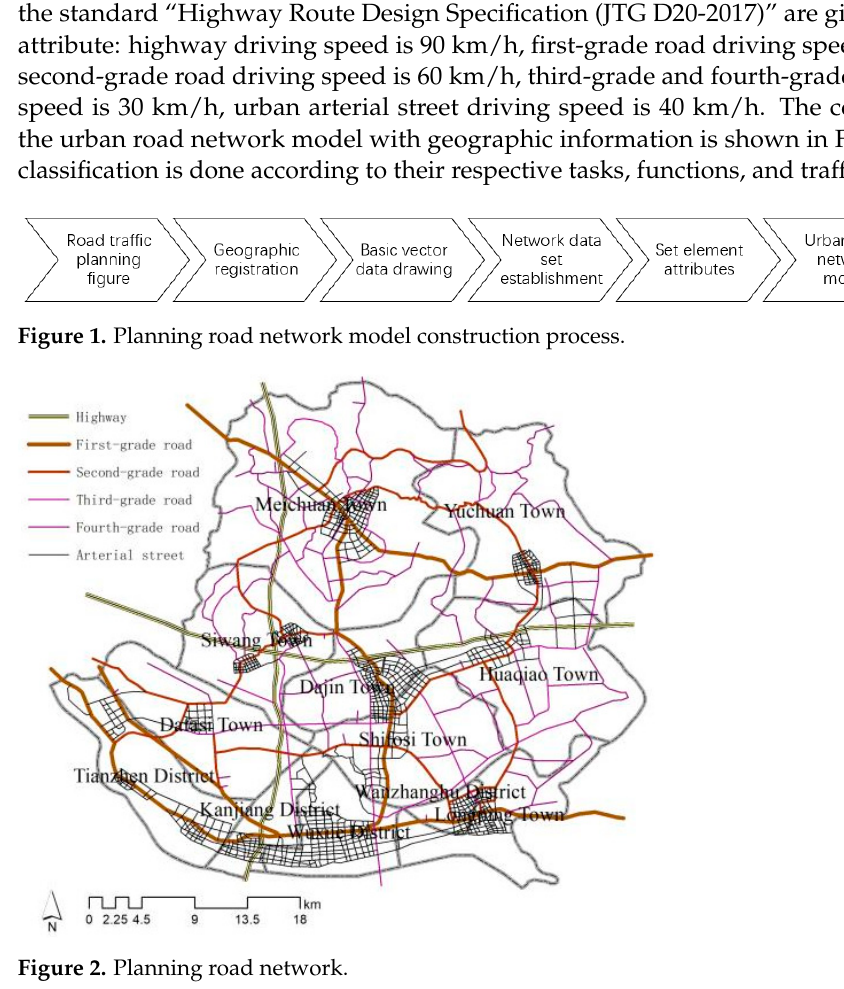
Figure 4. Number of base stations in each administrative region. 3.3. Test Methods Based on cell phone data, we mainly carried out research using ArcGIS software. We obtain the spatial distribution of travel OD, and then quantitatively analyze the main con ‐ tact directions and contact strengths among cities and towns in the city. Then, we under ‐ take an evaluation of the current planning scheme in four aspects, such as road network density and traffic accessibility, and make optimization suggestions. The research process is as follows (Figure 5). The first is spatial analysis of cell phone data. The cell phone data used in this study contain the geographical coordinates of the start and end points and the amount of traffic each day. We analyze people’s travel directions, which can be used to guide traffic plan ‐ ning [27]. Based on information on cell phone data and the principle of operability, this paper proposes the following analysis process to mine regional traffic contact intensity information. We first project the start and end points into the built study model. Accord ‐ ing to the direction from the starting point to the destination point, we take the average of the twenty ‐ day flow as the daily OD flow. We connect the start and end points through the data management tool, and here is the output of all travel OD lines. We symbolically display the corresponding number of traffic, and the linear line corresponds to the travel volume from small to large and from small to large to obtain the spatial distribution of passenger flow. Then, we use the location selection tool, number the cell phone data base stations of different towns, count the travel volume from each town to other towns, sort out the traffic trip table with the town as the statistical unit, obtain the OD contact of the towns and streets in Wuxue City, and analyze the main directions of outbound travel in each township, as well as the characteristics of the city’s internal connections, for the part of the comprehensive analysis of the planned road network.